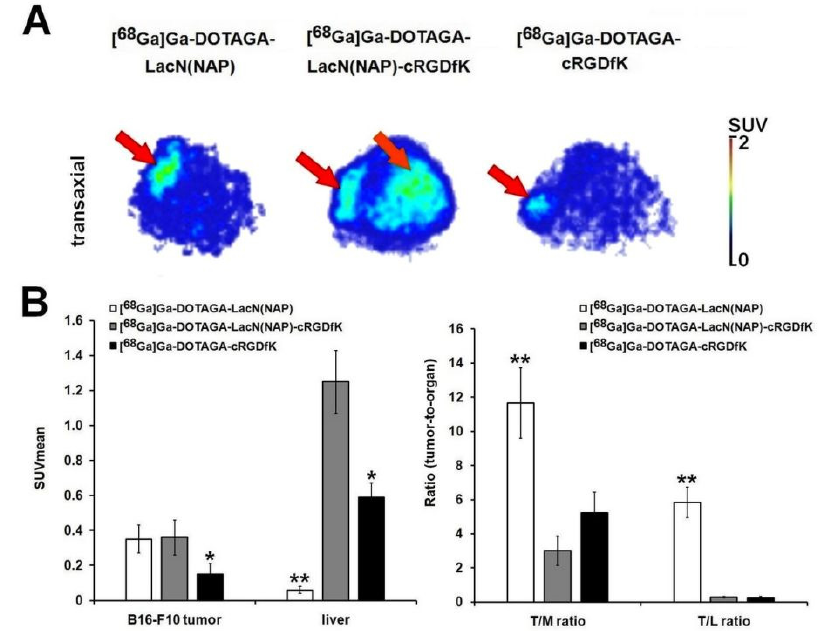
Figure 8. In vivo assessment of 68 Ga-labeled DOTAGA-LacN(NAP), DOTAGA-LacN(NAP)-cRGDfK, and DOTAGA-cRGDfK accumulation in subcutaneous B16-F10 tumors. Representative decay-corrected transaxial PET images of B16-F10 tumor-bearing mice 80 min after intravenous injection of the radiotracers and 10 ± 1 days after subcutaneous tumor cell inoculation ( A ). Quantitative SUV analysis of radiotracer uptake in B16-F10 tumors (n = 5/radiopharmaceutical) 80 min post injection, and 10 ± 1 days after subcutaneous injection of tumor cells ( B ). Significance levels: p ≤ 0.05 (*) and p ≤ 0.01 (**). SUV: standardized uptake value; T/M: SUVmean of tumor/SUVmean of muscle. T/L: SUVmean of tumor/SUVmean of liver. SUV values are presented as mean ± SD. Red arrows: B16-F10 tumor; orange arrow: liver.